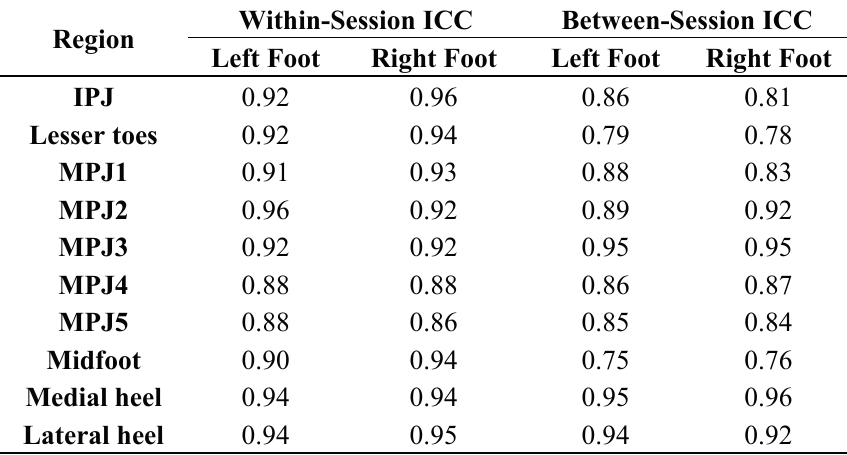
Table 2. Within-session and between-session intraclass correlation coefficients (ICCs) for the left and right